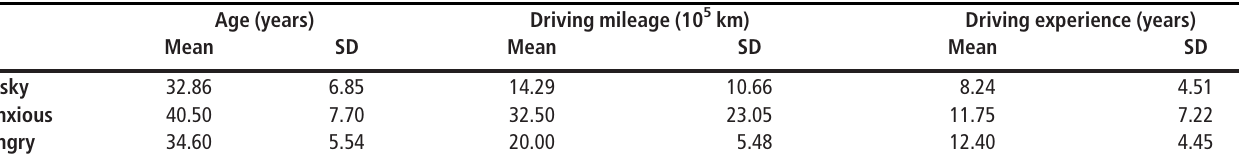
Table 3 MDSI-C Driving style according to self-reported